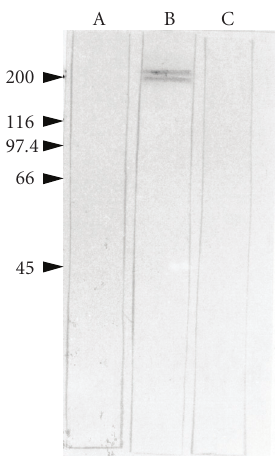
Figure 6: Immunoblot using mAb-001 on Cryptobia salmosit- ica lysate. Lane A: mAb-001 after immunoabsorption with live parasites; lane B: mAb-001 without immunoabsorption; lane C: hybridoma culture medium. The numbers on the left are molecular mass (kDa) of protein